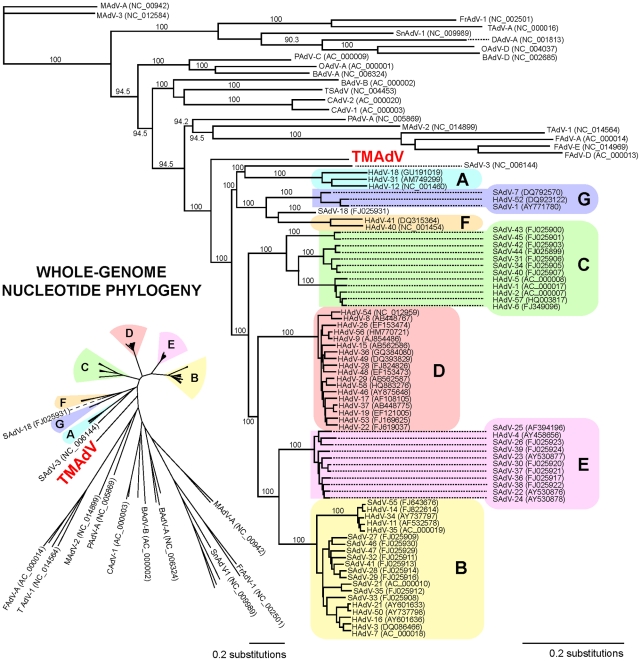
Whole-genome phylogenetic analysis of TMAdV.The whole-genome nucleotide phylogenetic tree is reconstructed from a multiple sequence alignment of all 95 unique, fully-sequenced adenovirus genomes in GenBank and TMAdV. Both rectangular cladogram and radial tree layouts are displayed. The branch corresponding to TMAdV is highlighted in boldface red. Abbreviations: HAdV, human adenovirus; SAdV, simian adenovirus; MAdV, mouse adenovirus, FrAdV, frog adenovirus; TAdV, turkey adenovirus; SnAdV, snake adenovirus; DAdV, duck adenovirus; OAdV, ovine adenovirus; BAdV, bovine adenovirus; PAdV, porcine adenovirus; TSAdV, tree shrew adenovirus; CAdV, canine adenovirus.